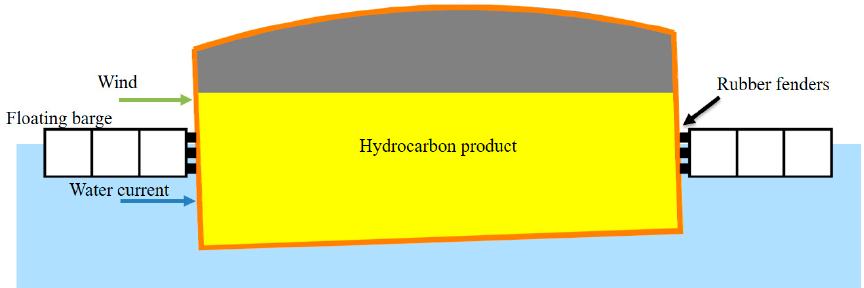
Figure 10. Floating tank enclosed by barges and subject to environmental loads.